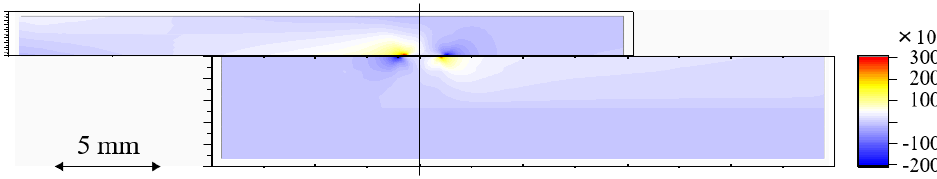
Figure 7. Size and FEM analysis model of the specimen.